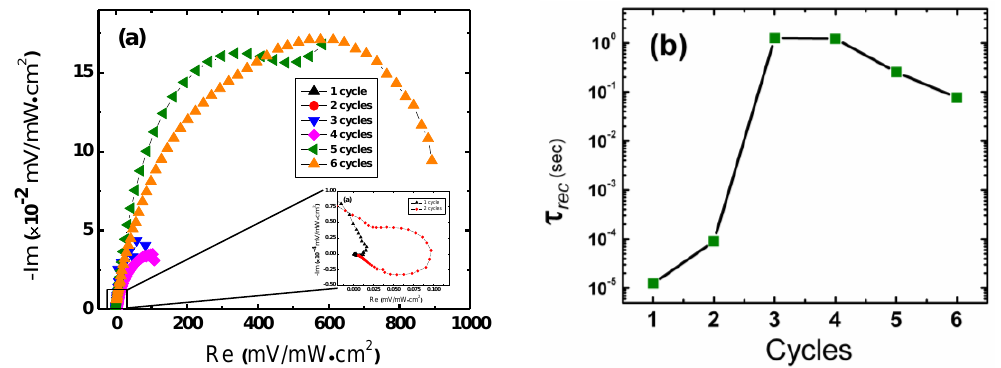
Figure 3. ( a ) Intensity modulated photovoltage spectroscopy (IMVS) Nyquist plot for ZnO:TiO 2 nanowire photoanode coated with CdSe quantum dots (QDs) by increasing SILAR deposition cycles under 1 sun illumination. ( b ) Recombination time constants calculated from IMVS data.